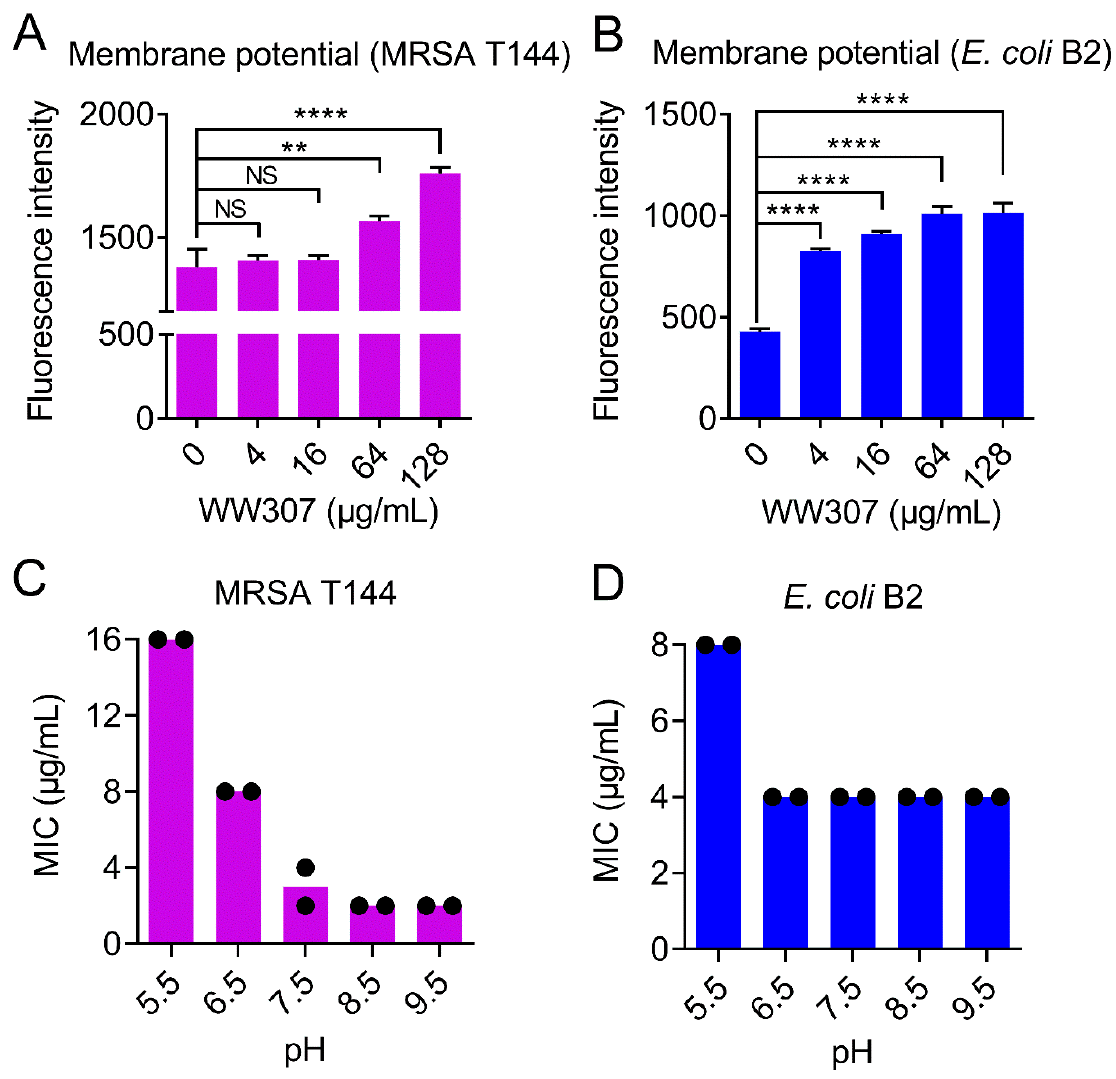
Figure 8. WW307 dissipates the ∆Ψ component of the proton motive force (PMF). ( A , B ) WW307 dissipated the membrane potential of MRSA T144 and E. coli B2, determined by monitoring the fluorescence intensity of 3,3’-dipropylthiadicarbocyanine iodide (DiSC 3 (5), excitation at 622 nm and emission at 670 nm). DiSC 3 (5)-labeled cells were incubated with WW307 at 37 ◦ C for 1 h prior to fluorescence intensity determination. ( C , D ) The shift to alkaline environment enhanced the antibacterial activity of WW307 against MRSA T144 and E. coli B2. In A and B, all data were expressed as mean ± SD, and the statistical significance was determined by non-parametric one-way ANOVA (NS, not significant; ** p < 0.01, **** p <